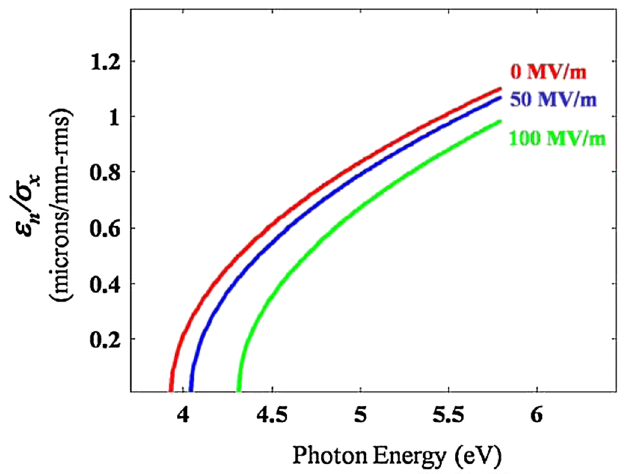
FIG. 6. (Color) The normalized emittance per rms beam size for Cu as a function of photon energy for the typical operating electric fields of metal cathodes in rf guns due to the Schottky reduction of the barrier as described in the text. The work function is assumed to be 4.31